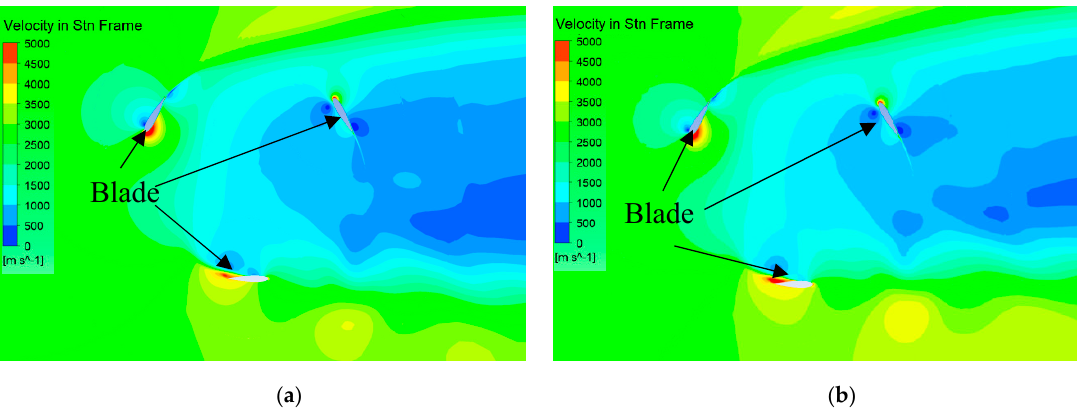
Figure 15. Cloud picture of velocity in the stand-alone turbine and twin-rotors turbine flow field. ( a ) Contour of velocity in the stand-alone turbine flow field, ( b ) contour of velocity of one of the rotors for the twin-rotors turbine flow field.